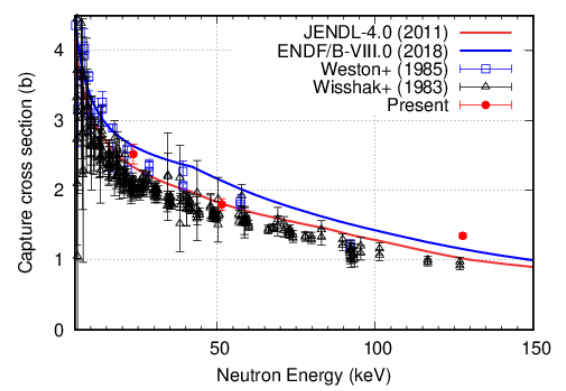
Fig. 7. Neutron capture cross section of 243 Am. The present experimental results are compared with past experimental data and evaluated cross